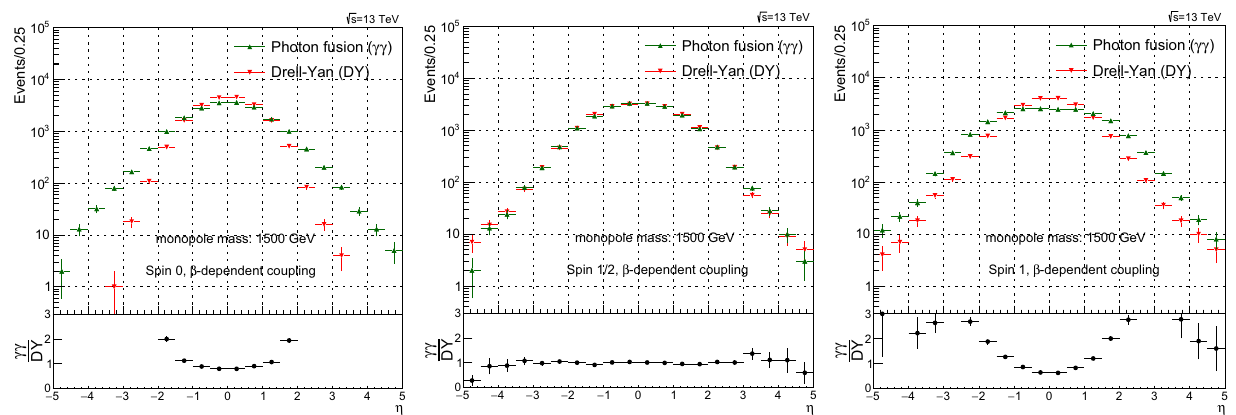
Fig. 24 The monopole pseudorapidity η distributions of spin-0 (left), spin- 1 / 2 (centre) and spin-1 monopoles (right) for both the photon-fusion √ s = 13 TeV and for κ = 1. The LUXqed and NNPDF23 PDFs were used for the PF and the DY process, and the Drell–Yan mechanisms at respectively